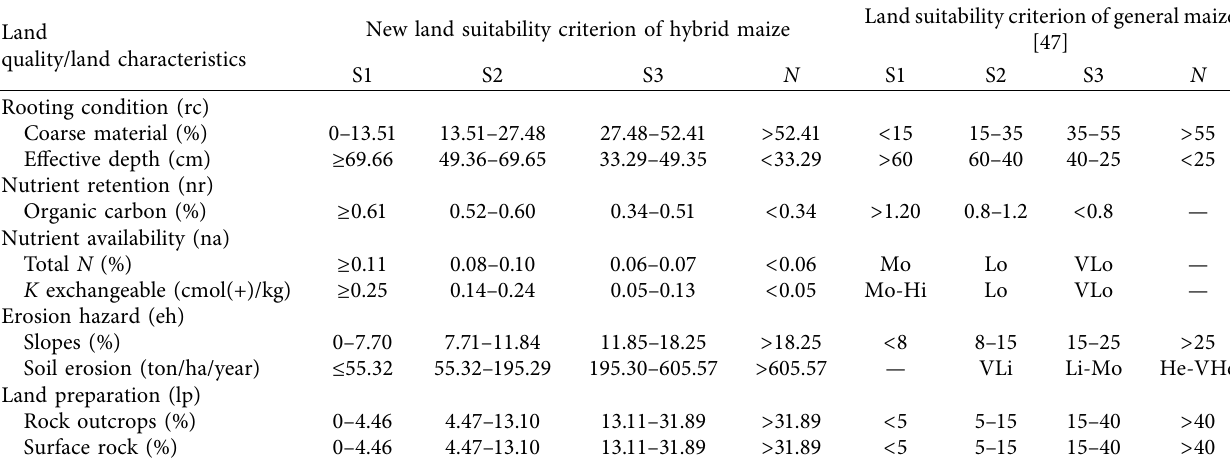
Table 9: Comparison of new and general land suitability criteria with land quality and